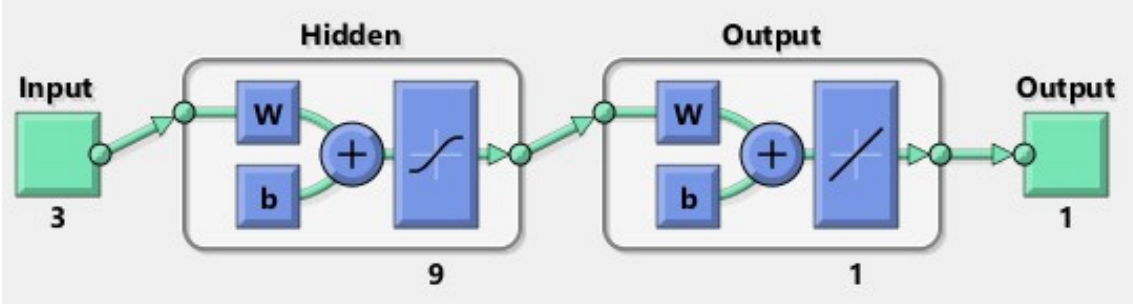
Figure 3. The ANN model basic structure.